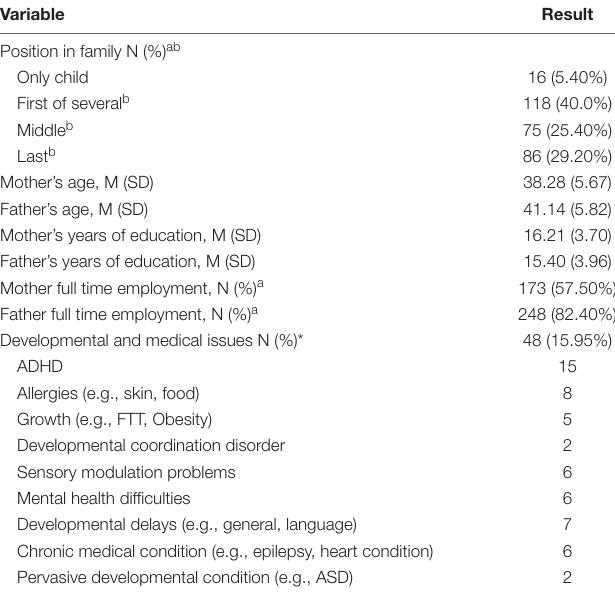
TABLE 1 | Background